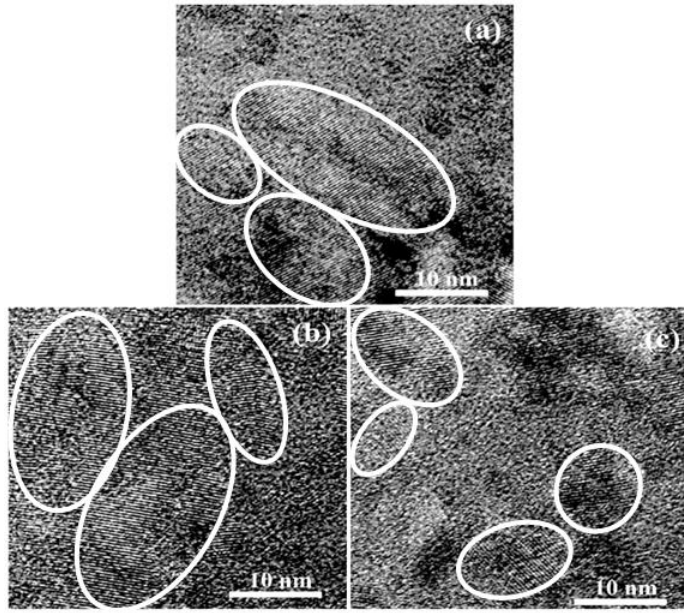
Figure 2. Transmission electron microscopy (TEM) images of ( a ) the un-doped nc-Si film; and ( b ) P-doped nc-Si film; and ( c ) B-doped nc-Si film.